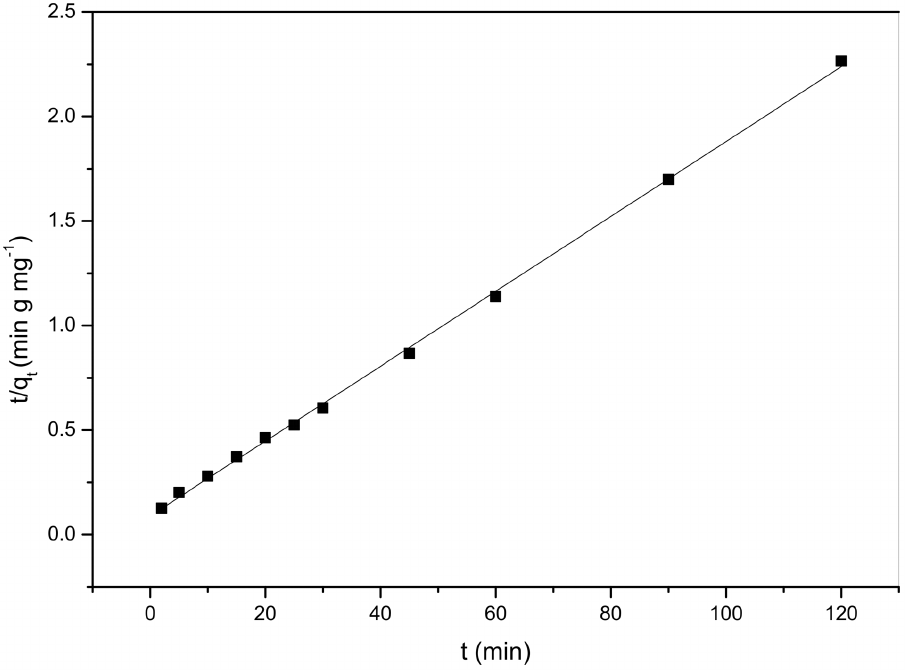
Figure 7. Plots of pseudo-second-order kinetic model equation for the biosorption of Cd 2 + on the Sargassumfusiforme .